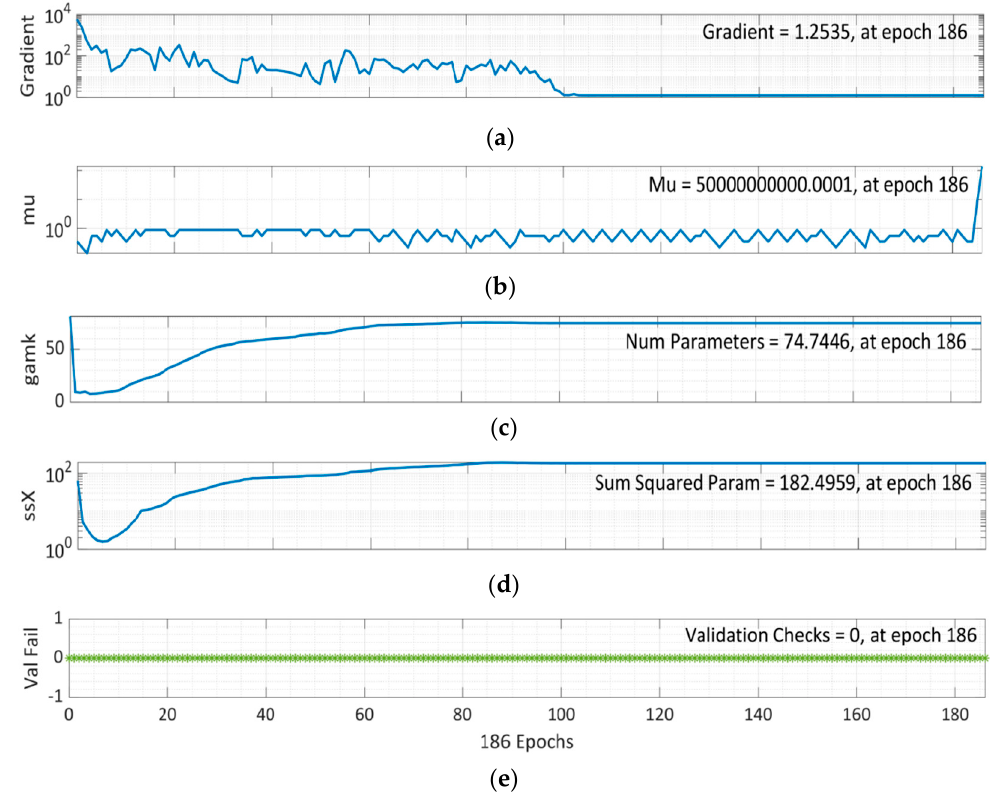
Figure 13. Training State of BR Algorithm: ( a ) Gradient graph at epoch 186; ( b ) Mu graph at epoch 186; ( c ) Number parameter graph at epoch 186; ( d ) S.S.X. graph at epoch 186; ( e ) Validation checks graph at epoch 186.